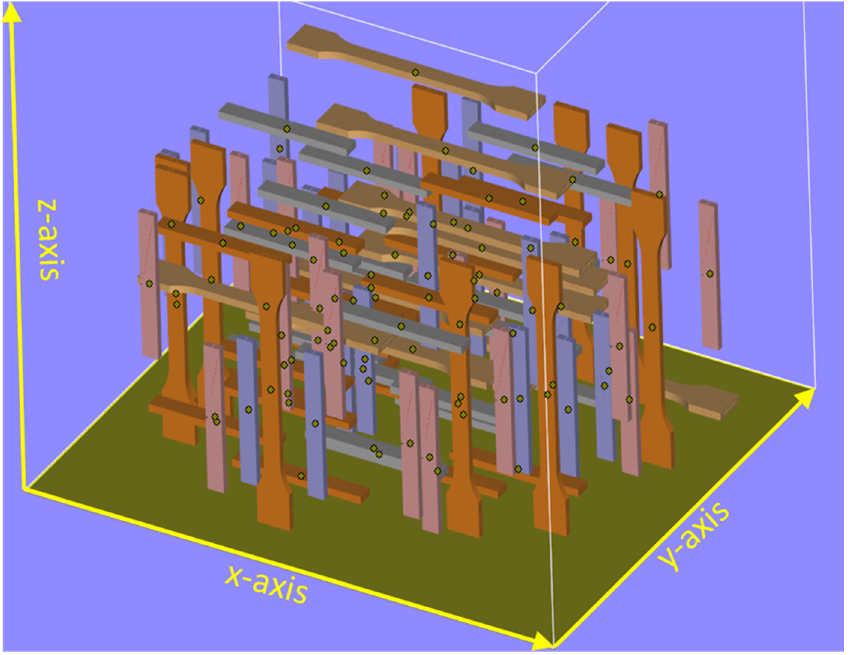
Figure 3. Randomly distributed specimens as built for both investigated powders.